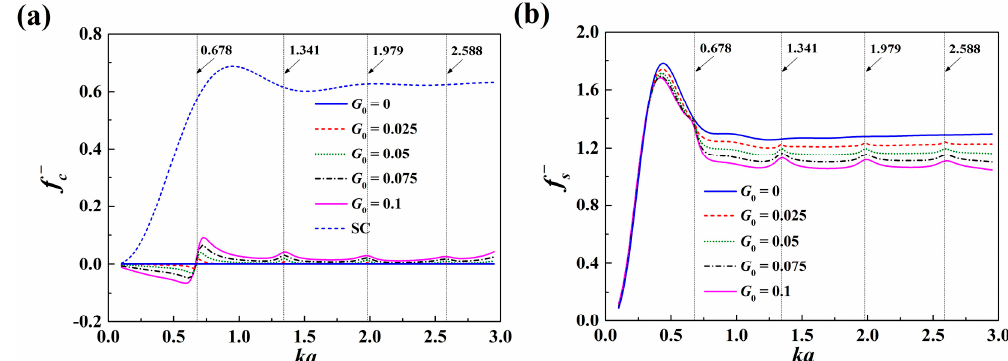
Figure 3. Effect of the porous parameter G 0 on the mean drift wave force on the interior column and the exterior porous shell using the near-field formulation ( b = 2 a and d = 3 a ): ( a ) f − c ( b ) f − s . The effect of the radius of the exterior porous shell and the effect of the water depth on the mean drift wave force acting on the impermeable column, the porous shell and the system as a whole are shown in Figures 4 and 5, respectively. As shown in Figure 4, the total mean drift wave force on the system increases with the increase of b . This is due to that the system interacts with more incoming waves as the radius of the exterior porous shell increases. It is also found that the frequencies of the small peaks move to the high-frequency region as the shell gets closer to the enclosed column. In Figure 5, the effect of the water depth gets less apparent as ka increases. This is due to the fact that in short incident waves, the fluid velocity decays quickly downward along the gravity direction.